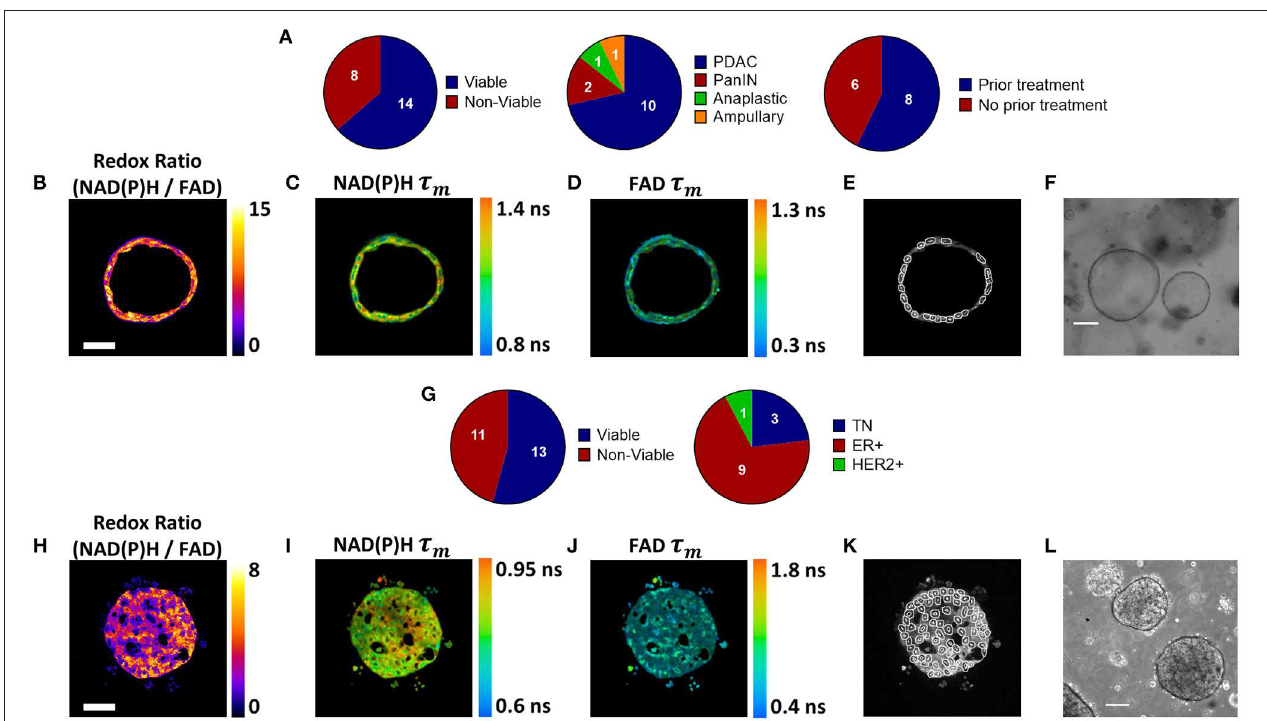
FIGURE 1 | Patient-derived tumor organoid generation and optical metabolic imaging. (A) Pie charts depicting the success rate for generating viable organoids from patient pancreatic lesions (left), the distribution of PDAC, PanIN, anaplastic cancer, and ampullary cancer among successfully generated organoids (center), and the distribution of previously treated vs. untreated tumors among successfully generated organoids (right). Representative redox ratio (B) , NAD(P)H τ m (C) , and FAD τ m (D) images of an untreated pancreatic organoid taken 6 days after surgical resection (Patient PC14). Scale bar is 50 µ m (E). Masks of individual cell cytoplasms overlaid onto NAD(P)H intensity image (F) . Representative brightfield image of pancreatic organoids (Patient PC14). Scale bar is 200 µ m. (G) Pie charts depicting the success rate for generating viable organoids from patient breast tumor biopsies (left), and the distribution of receptor subtypes among successfully generated organoids (right). Representative redox ratio (H) , NAD(P)H τ m (I) , and FAD τ m (J) images of an untreated breast cancer organoid taken 30 days after biopsy (Patient BC9). Scale bar is 50 µ m. (K) Masks of individual cell cytoplasms overlaid onto NAD(P)H intensity image. (L) Representative brightfield image of breast cancer organoids (Patient BC9). Scale bar is 200 µ